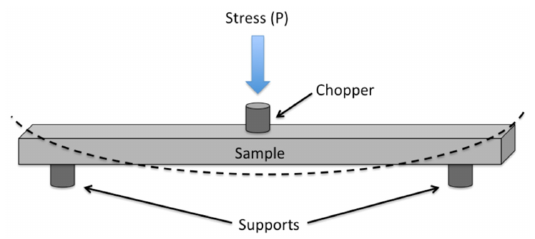
Figure 2. Schematic diagram of the static bending test to characterize the reduced scale